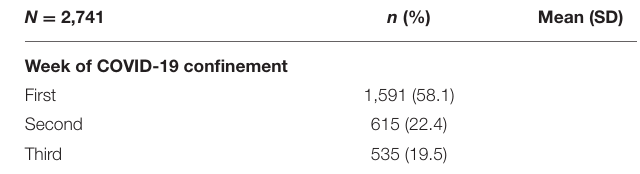
TABLE 2 | Characteristics of the study population and health risk behaviors during COVID-19